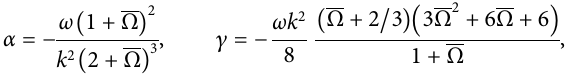
FIGURE 1 | Dimensionless group velocity deviation between fi nite and in fi nite depths as a function of the dispersive parameter for several values of the dimensionless vorticity. In dimensionless terms, the units of acceleration and length are the acceleration of gravity g and 2 π ( g (cid:2) 1 and k (cid:2)